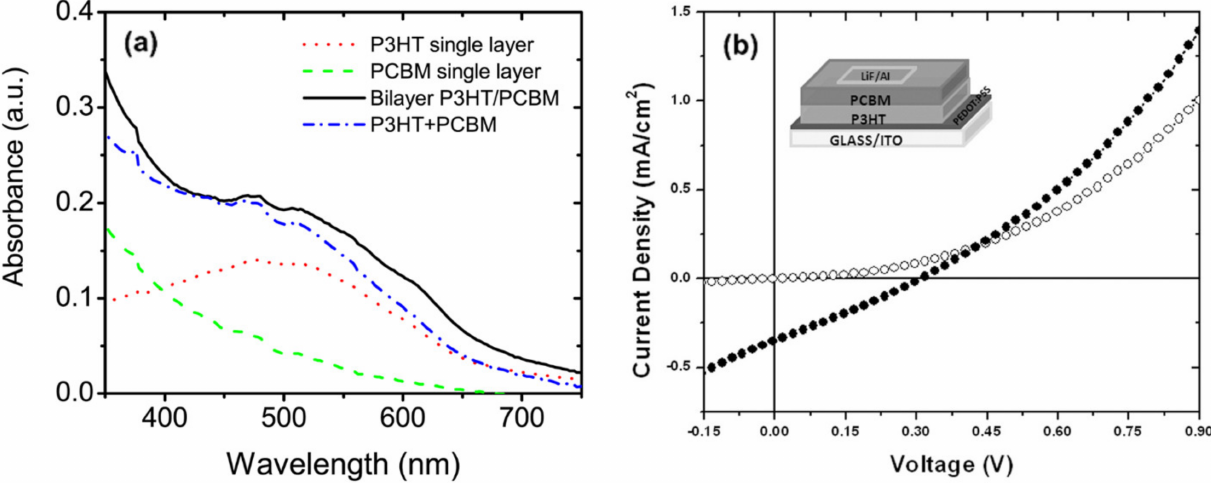
Figure 4. ( a ) UV–Vis absorption spectra of P3HT, PCBM, P3HT/PCBM and P3HT:PCBM layers and ( b ) J–V characteristics of the cell prepared with P3HT/PCBM stacked layers. Inset: Schematic representation of the prepared bilayer device. Reprinted with permission from [38]. Copyright 2012 AIP